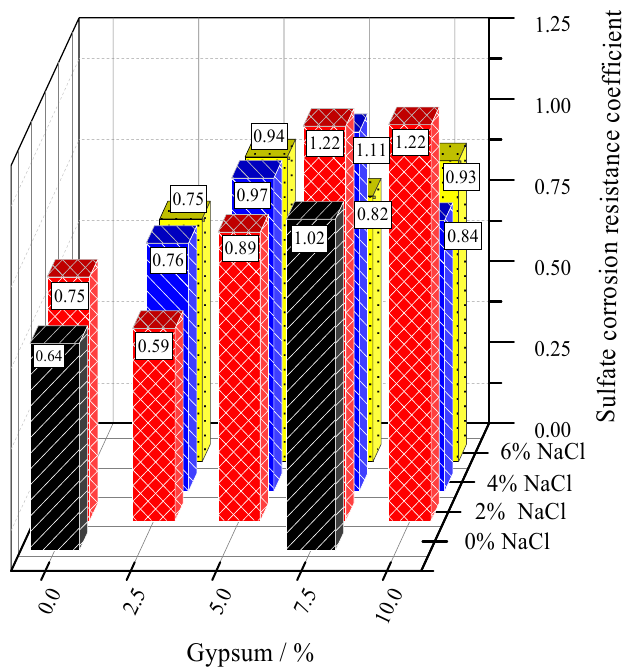
Figure 11. Sulfate corrosion resistance coefficient at 90 days.